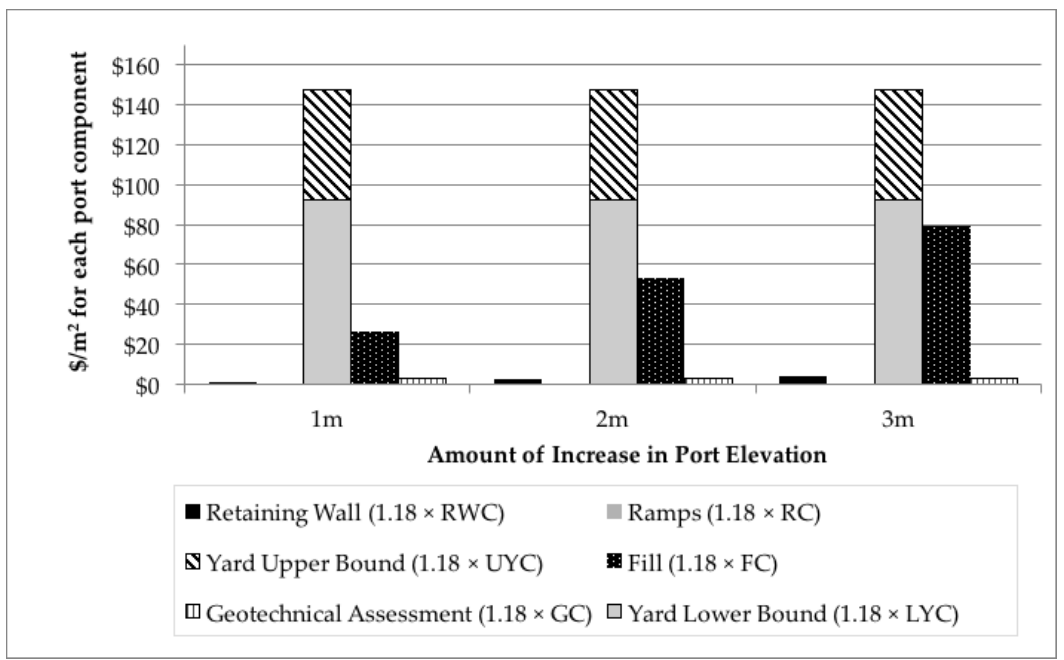
Figure 6. Cost to elevate and retrofit per square meter of port area by cost of component.